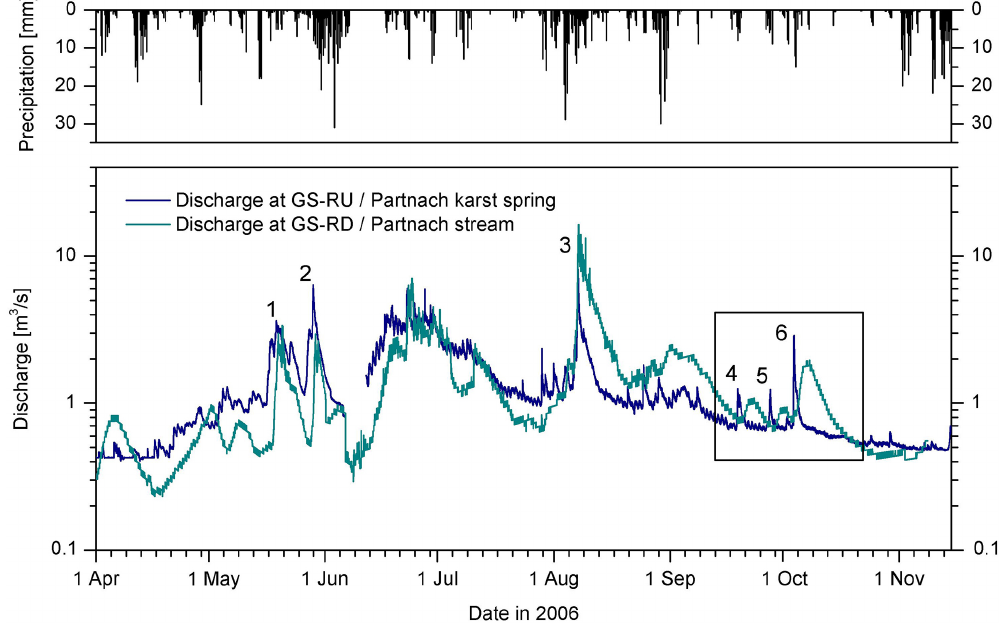
Figure 8. Hydrographs at the upstream (Partnach karst spring, site GS-RU) and downstream (Partnach stream, site GS-RD) gauging stations in the Reintal in 2006. Precipitation data (6h time step) was obtained from the weather station at the Zugspitze